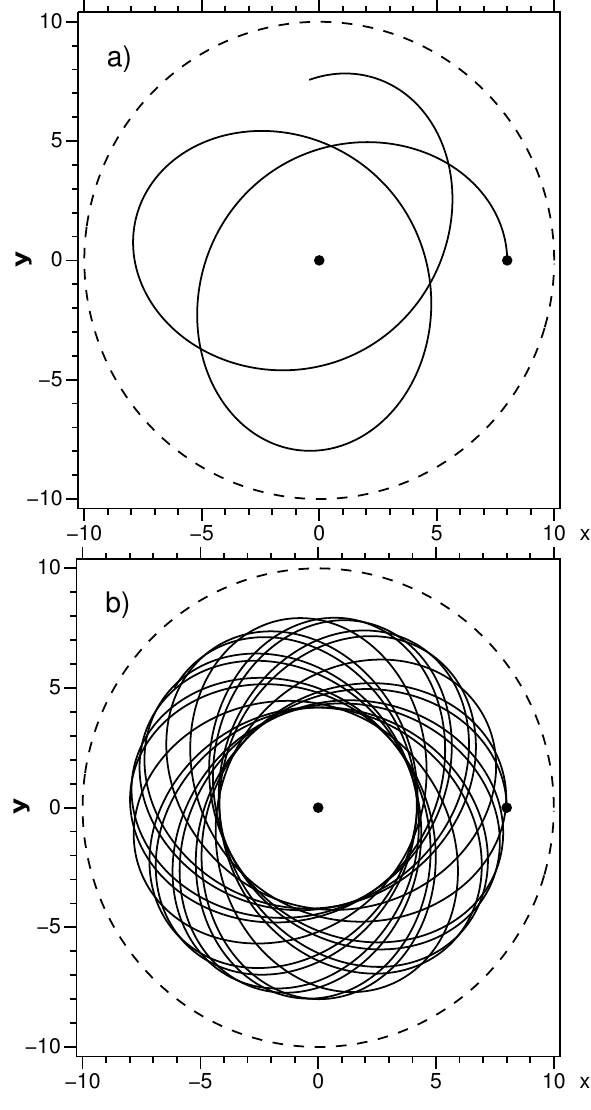
Fig. 3. Example electron orbit in potential (13) with V 0 = 20kV, r o = 19m and W ⊥ tot = − 1 . 5keV, after 5 µ s integration (a) and after 40 µ s integration (b) .